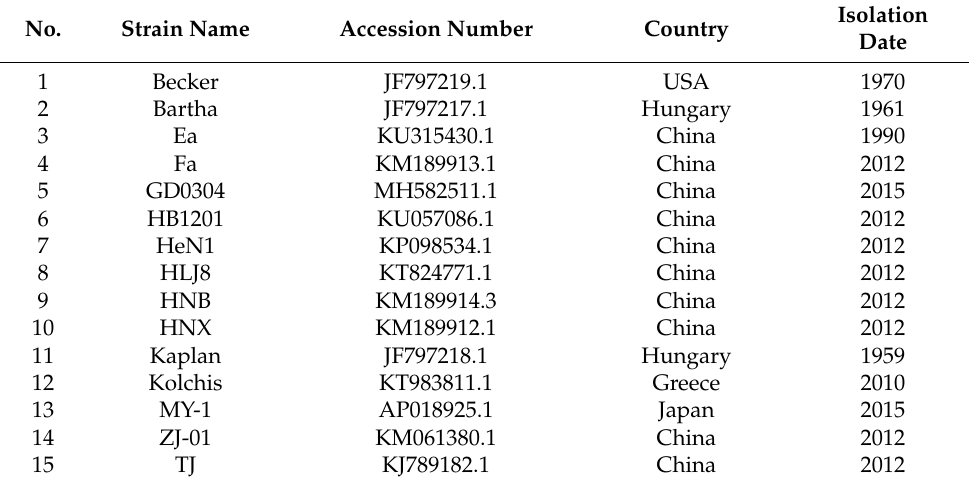
Table 1. Complete genome sequence information of pseudorabies viruses in the National Center of Biotechnology Information databases.